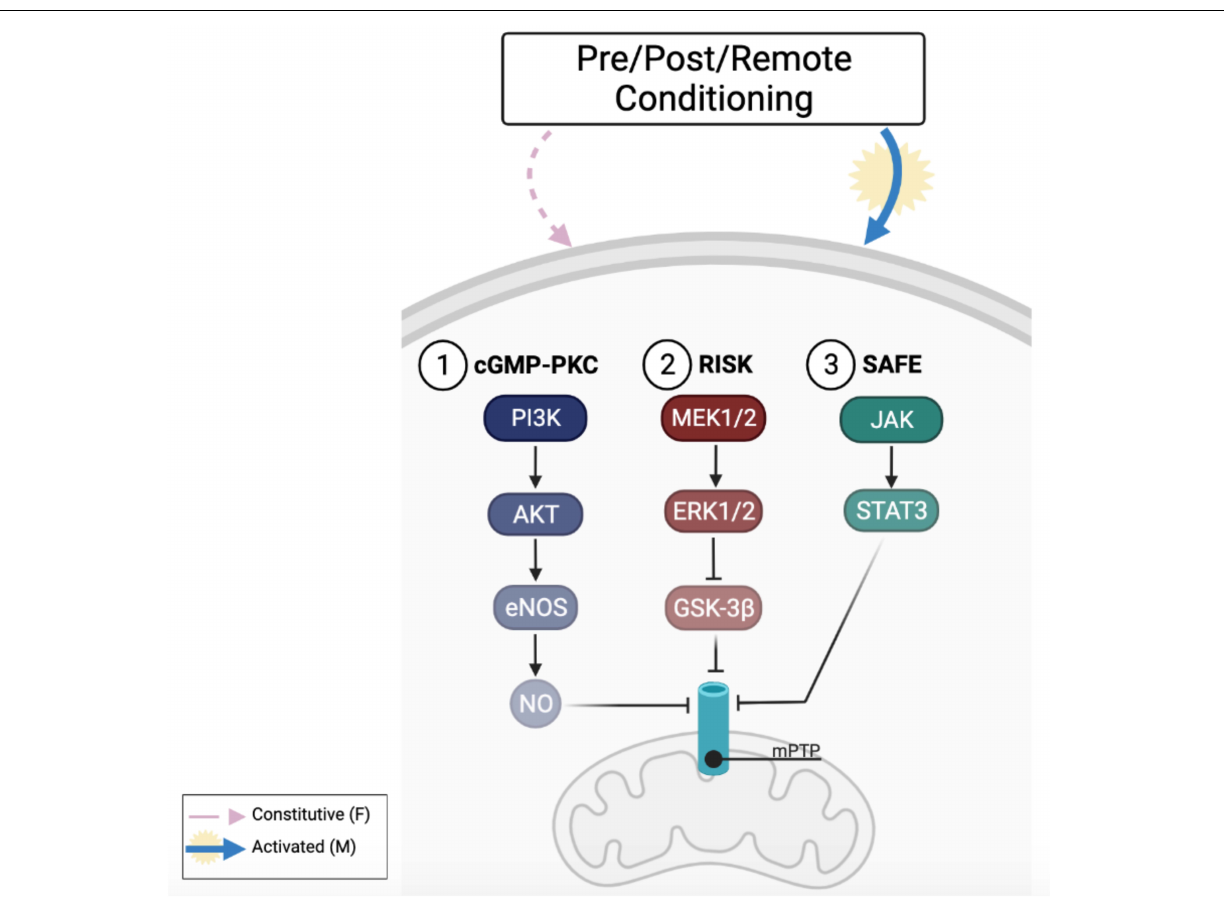
FIGURE 1 | Cardioprotective pathways activated by conditioning maneuvers and sex-related response. Animal models suggest that males (M) seem to respond better to conditioning cardioprotective maneuvers through the activation of cGMP-PKC (1), RISK (2) and SAFE (3) pathways than female (F) that constitutively express these pathways. Figure created in